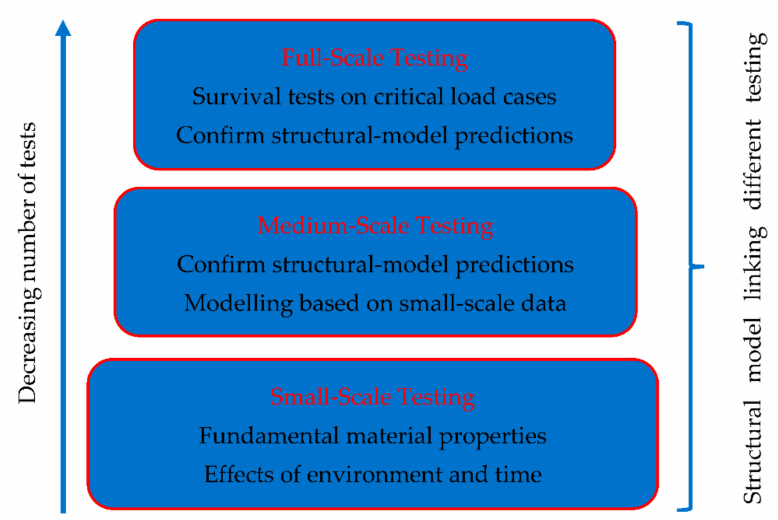
Figure 20. Pyramid principle for structural analysis and